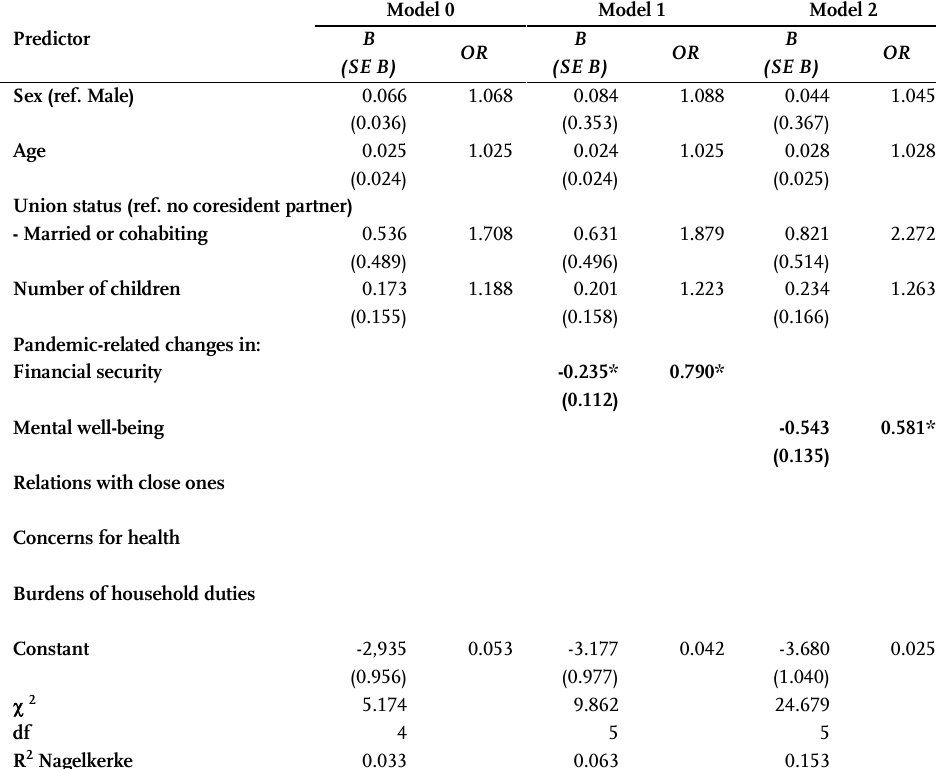
Table 4 : Logistic regression: Predicting the declared negative change in intention to have a child (postponing or foregoing) due to selected consequences of the pandemic, n=246 Model 0 Model 1 Model 2